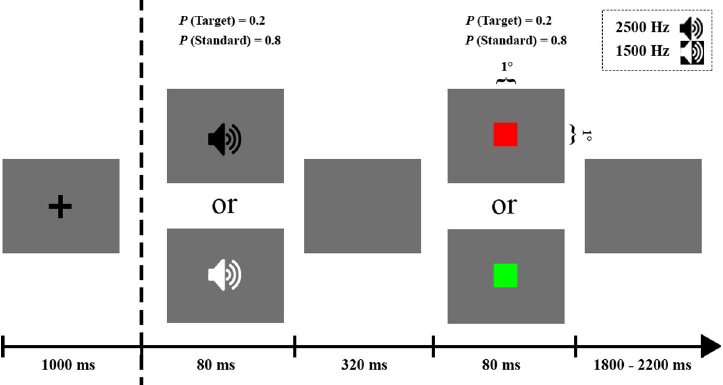
Fig 1. Stimulus dimensions and timeline of the oddball dual-task. Each trial started with presentation of auditory stimuli (target or standard) followed by presentation of visual stimuli (target or standard) 400 ms later. At the beginning of each block or after the auditory targets were queried, a fixation cross was displayed for 1000 ms prior to the start of the trial.